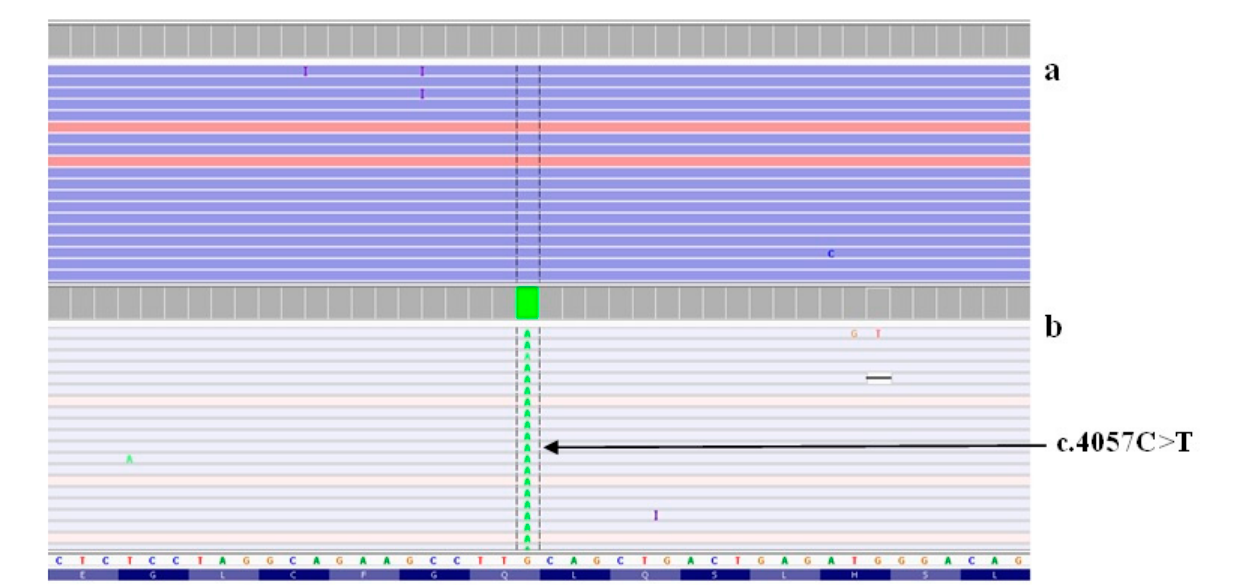
Figure 2. The alignment of reads in the region of exon 20 of the STRC gene visualized in the IGV genomic browser. ( a ) Normal, and ( b ) c.4057C>T mutation.